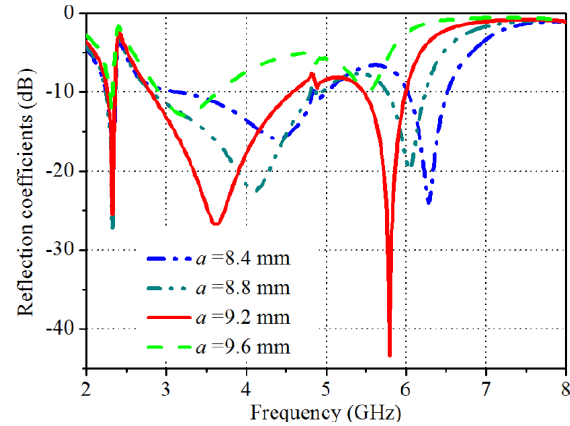
Figure 5: Effect of the design parameter a on the reflection